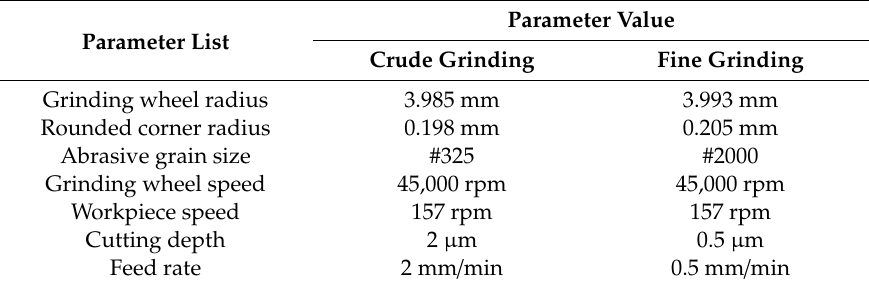
Table 3. Ultra-precision grinding machining parameters for tungsten carbide